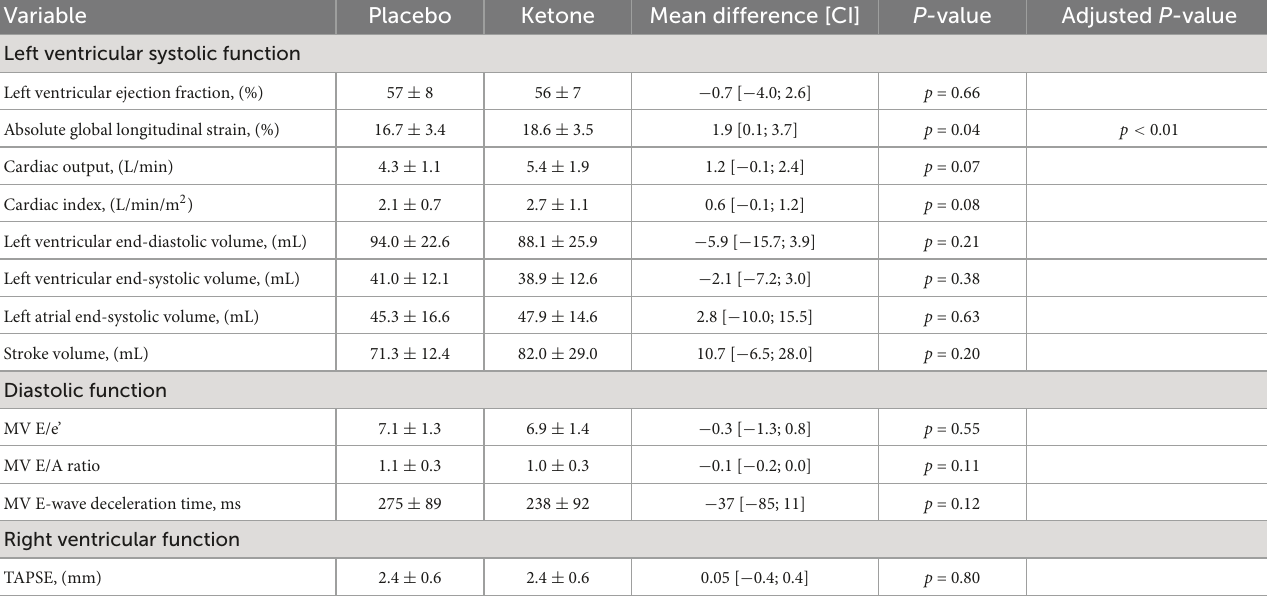
TABLE 2 Differences in echocardiographic parameters between oral ketone esters and placebo. Variable